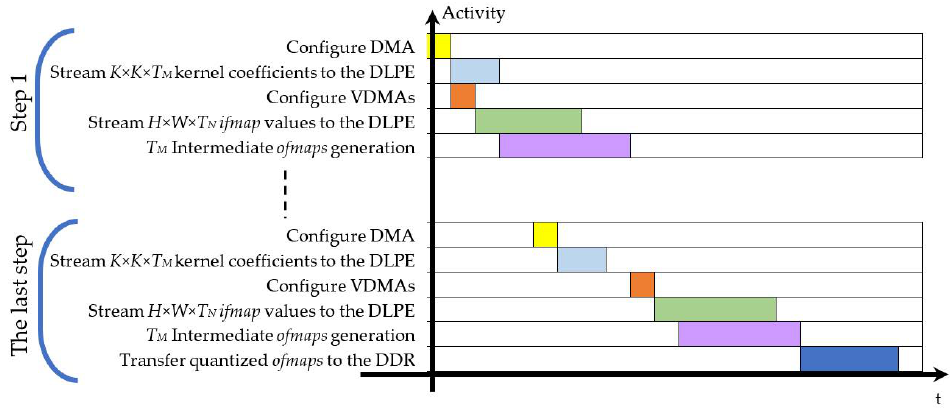
Figure 10. The computational flow of the architecture in Figure 9.